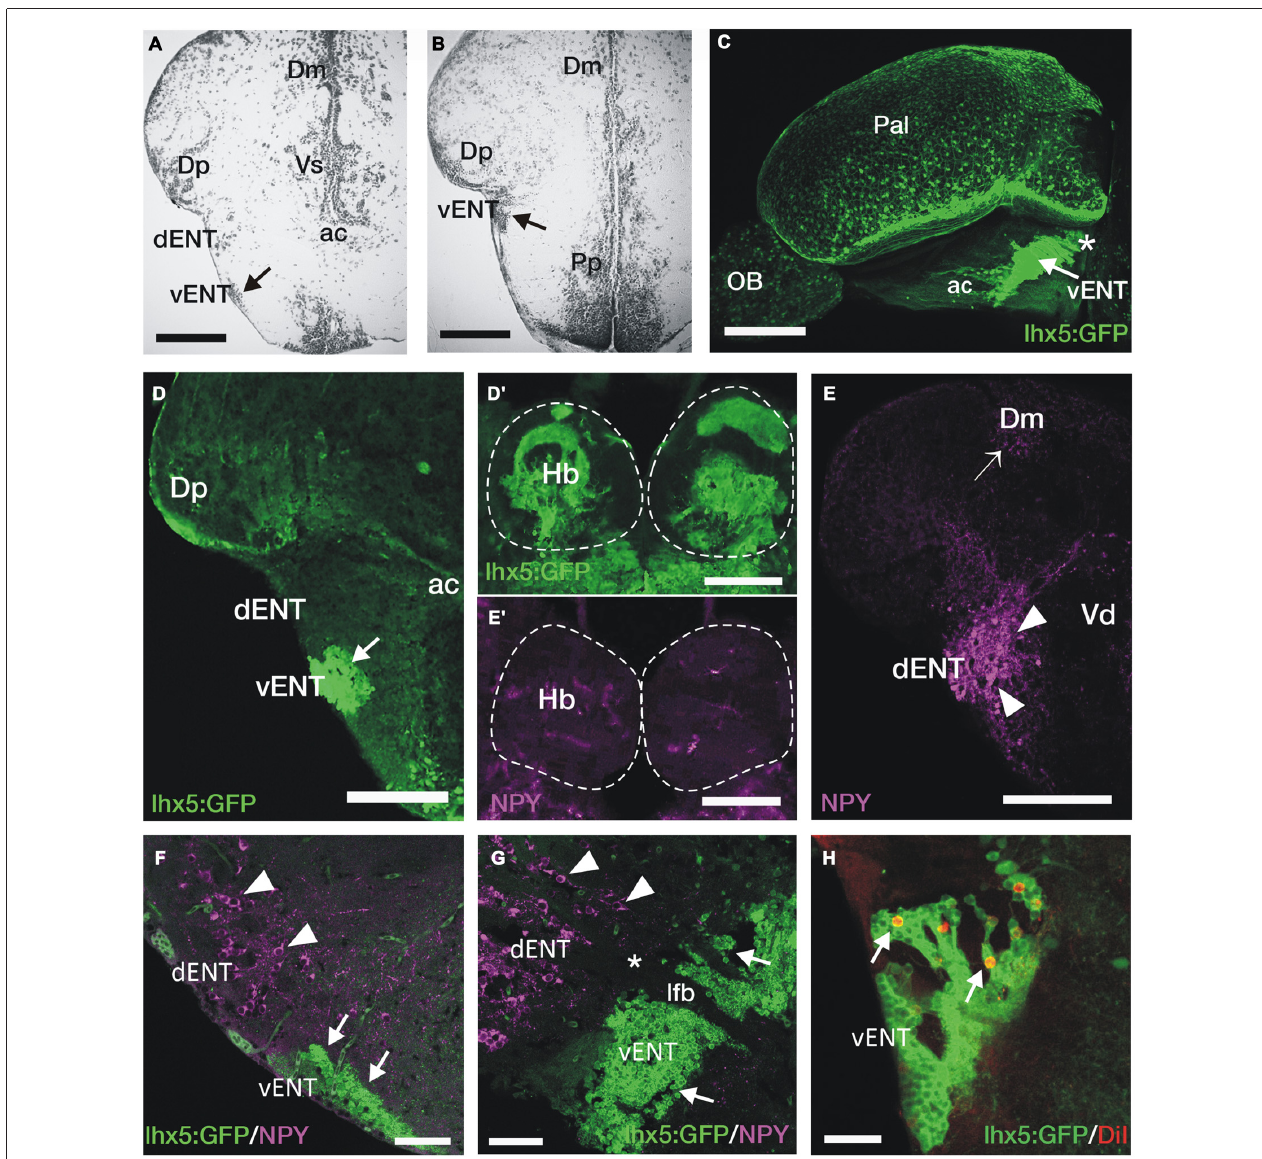
FIGURE 4 | GFP+ vENT neurons and habenular innervation in Tg(lhx5:GFP) b1205 transgenic zebrafish. Images are transverse sections (A,B,D–F,H) , lateral view (C) or parasagittal section (G) of adult zebrafish wild type (A,B,E,E (cid:48) ) or Tg(lhx5:GFP) b1205 (C–D (cid:48) ,F–H) brains. (A,B) Nissl stained sections showing the cytoarchitecture of the vENT (arrows in A and B ) and dENT at anterior (same level as shown in schematic Figure 2C ) and posterior (same level as shown in schematic Figure 2D ). By following serial sections it can be noted that only the vENT extends into caudal areas of the telencephalon (arrow in B ). (C) Lateral view of intact brain from a Tg(lhx5:GFP) b1205 fish (anterior to the left) showing GFP+ cells in the vENT (arrow), among other structures and areas. Note that vENT cells form a band extending from the level of the anterior commissure (ac) into the telencephalic peduncule (indicated with a star). (D) GFP+ cells in the vENT (arrow), but not in the dENT, of a Tg(lhx5:GFP) b1205 fish. (D (cid:48) ) Dense neuropil of GFP+ fibers in the habenula of a Tg(lhx5:GFP) b1205 fish. Dotted lines mark the habenulae. (E) NPY+ cells in the dENT and fibers (arrowheads) in the medial area of the pallium (Dm; arrow). (E (cid:48) ) Very few NPY+ fibers are found in the habenulae. Note that some of the labeling observed in the image is caused by autofluorescence of blood vessels. (F,G) Double immunohistochemistry against NPY and GFP in transverse (F) and parasagittal ( G ; anterior to the left) sections of a brain from a Tg(lhx5:GFP) b1205 fish. Note that NPY+ cells are restricted to the dENT (arrowheads). GFP+ cells were observed in the vENT (arrows). Note in (G) that the dENT (arrowheads) does not extend as far caudal as the vENT (arrows) and there is a clear gap (star) between the two nuclei. Bundles of axons from the lateral forebrain bundle (lfb) travel through both nuclei. (H) Retrogradely DiI labeled cells (arrows) in the vENT of a Tg(lhx5:GFP) b1205 fish after tracer application to the habenula. Scale bars: 150 µ m in (A,B,D–E (cid:48) ) ; 250 µ m in (C) ; 100 µ m in (F,G) and 50 µ m in (H)